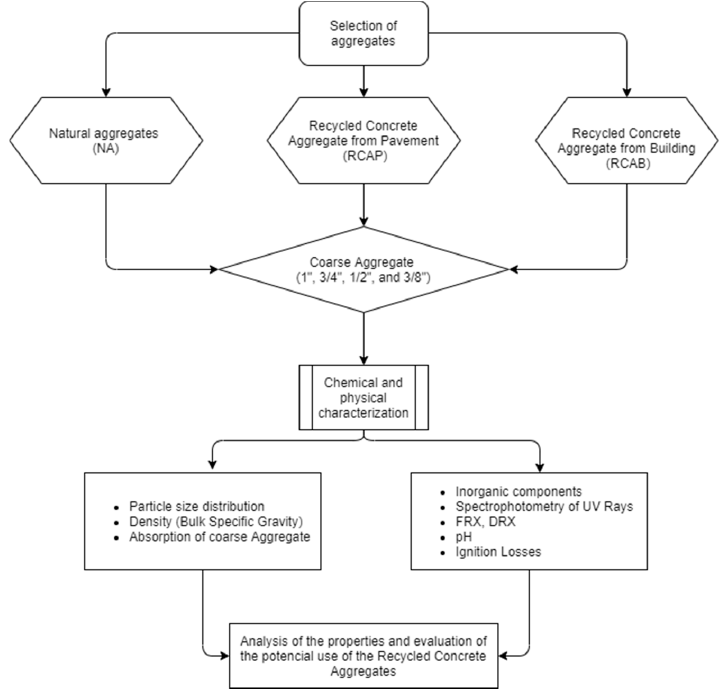
Figure 2. Flow chart of the study plan.